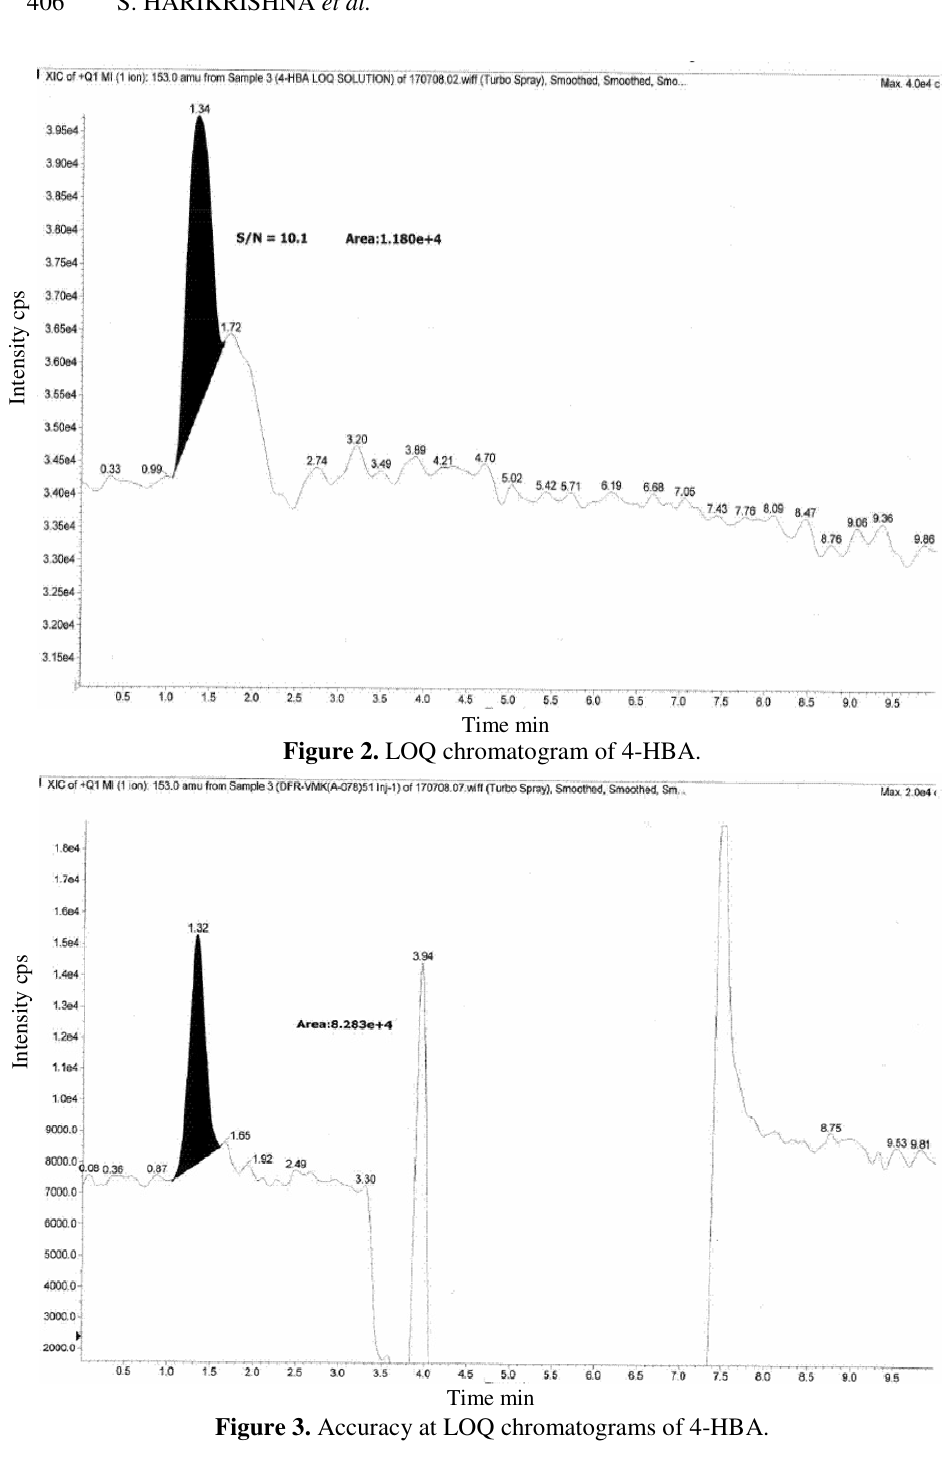
Figure 3. Accuracy at LOQ chromatograms of